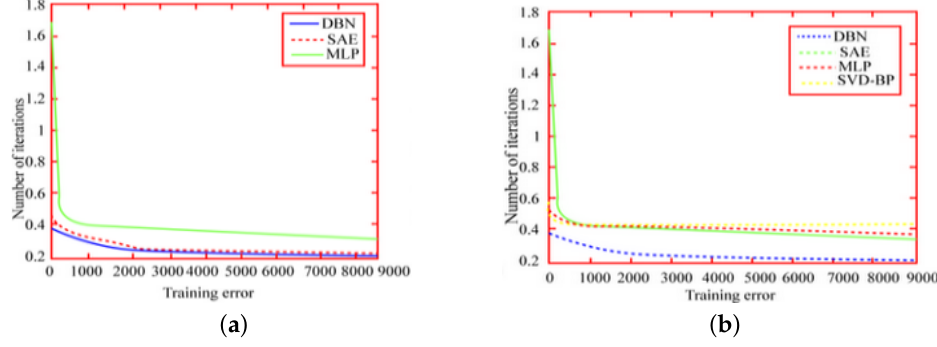
Figure 11. Training error of the DL-EWP model compared with the reference models in the classifica- tion stage. ( a ) Comparison of the training errors of three deep network models. ( b ) Comparison of the training errors between the DBN network and three shallow network